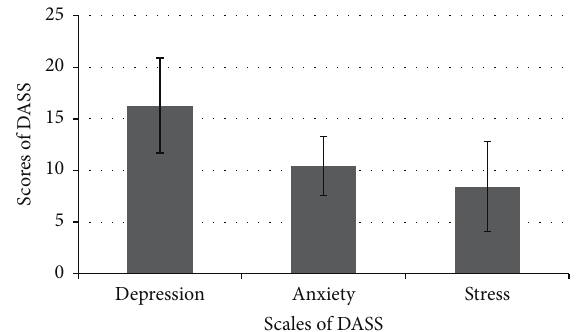
Figure 1: The mean and SD of the subscales of DASS in the participants of the study.